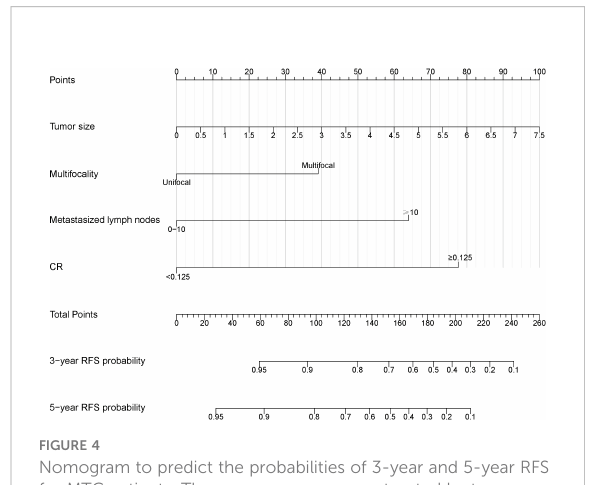
FIGURE 4 Nomogram to predict the probabilities of 3-year and 5-year RFS for MTC patients. The nomogram was constructed by tumor size, multifocality, metastasized lymph nodes and CR. RFS,